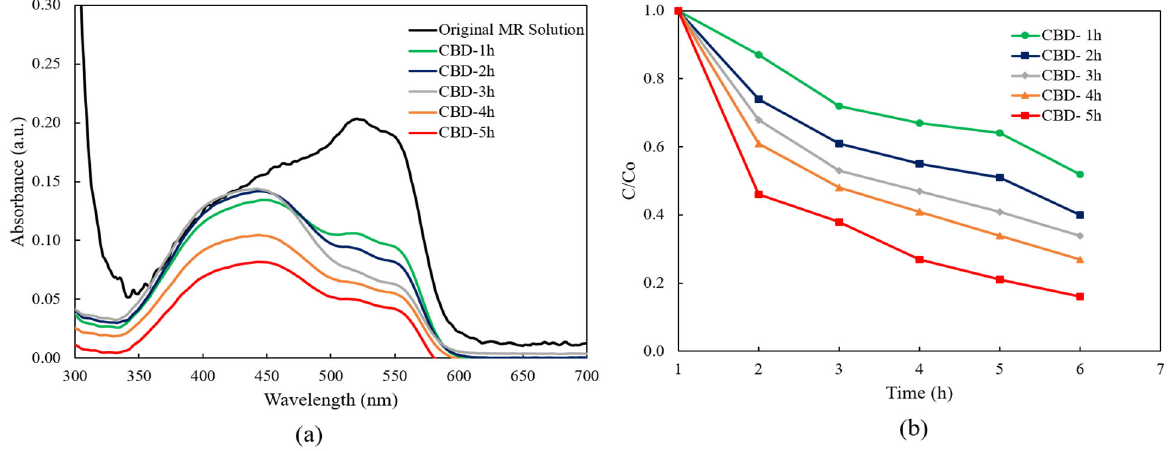
Figure 6. ( a ) The absorption spectra of MR solution for ZnO nanorods with different reaction times and ( b ) plot of C/Co versus the degradation reaction time.